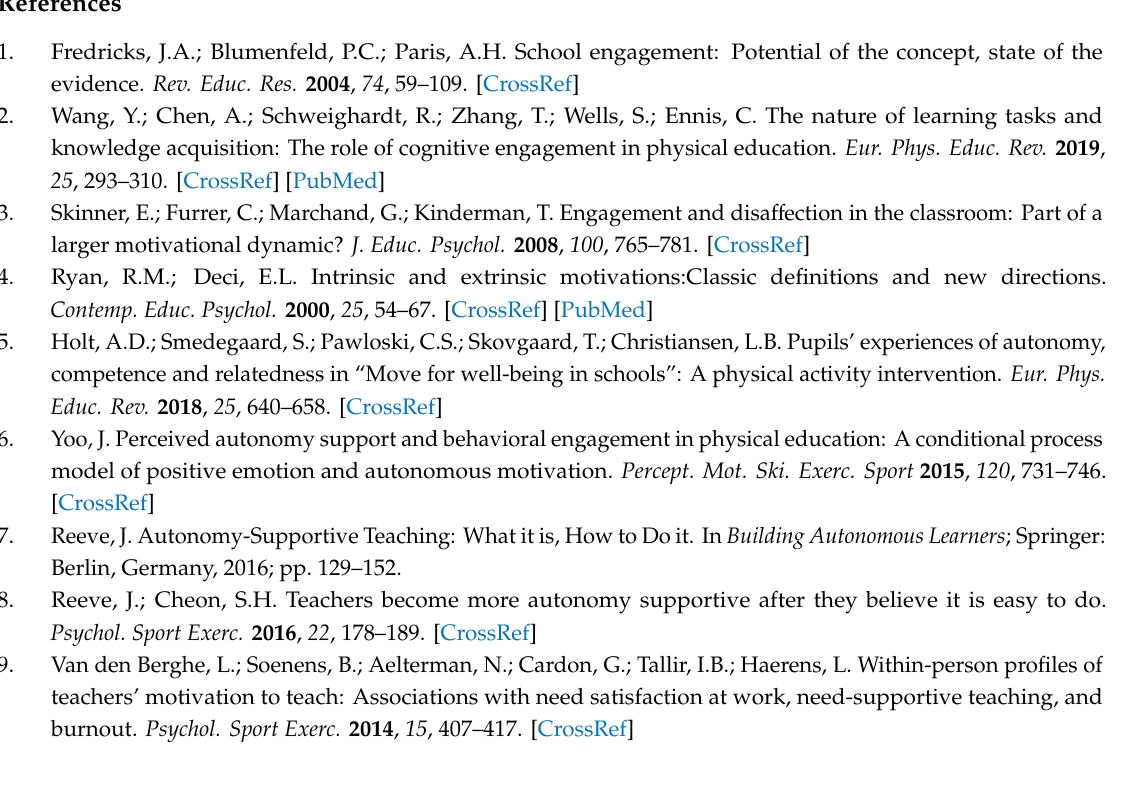
Table S1: Teachers’ need satisfaction, Table S2: Teachers’ need thwarting, Table S3: Students’ behavioural engagement, Table S4: Students’ perceptions of autonomy